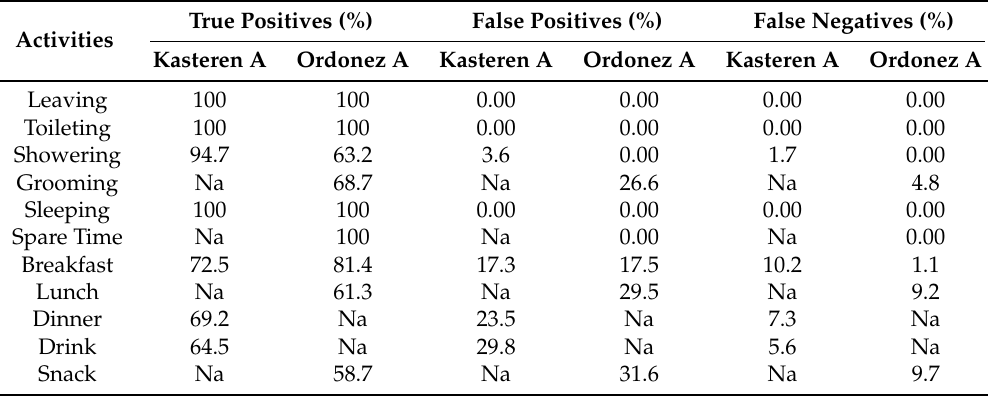
Table 10. Activity recognition performance for Kasteren A and Ordonez